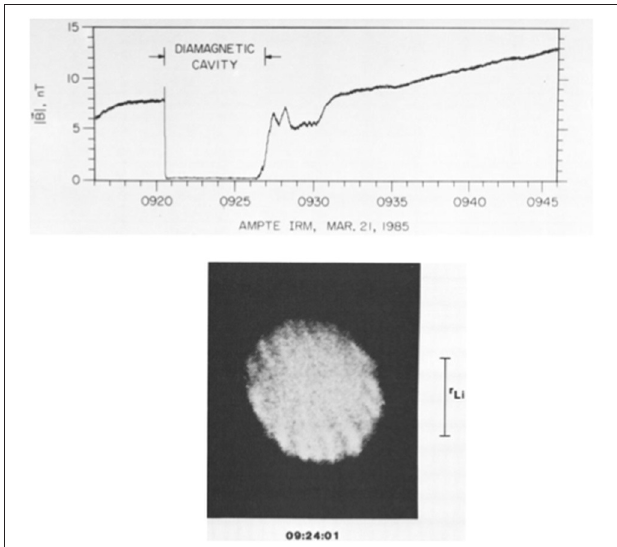
FIGURE 1 | Results from the 21 March 1985 AMPTE magnetotail release. [top] Magnetic field magnitude measured by the IRM satellite showing the magnetic cavity. The diamagnetic cavity, with |B| ∼ 0, appears right at the release time, 9:20:38, and extends out to 9:26:20, as the cavity collapses and the cloud moves relative to the spacecraft. [bottom] CCD image of the cloud at time of maximum expansion, t = 9:24:01, when the cloud radius is 210km ∼ the barium ion gyroradius, r Li . The bright areas correspond to higher plasma density. The top panel is from Figure 12, the bottom panel from Figure 18 in Bernhardt et al. (1987). The figures are reproduced with permission from The American Geophysical Union.